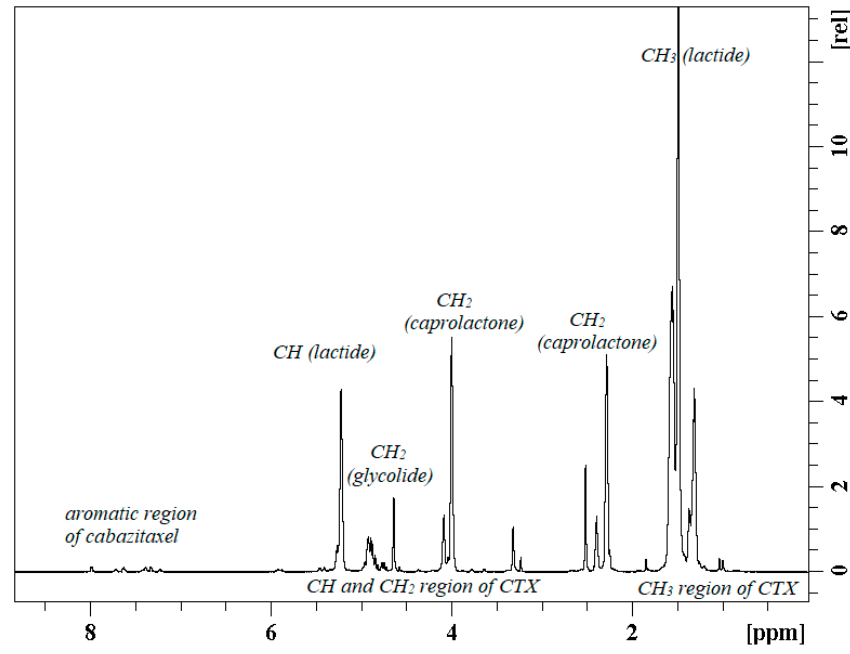
Figure 7. 1 H NMR spectrum of (PGCL/PLGA) + CTX patches in DMSO-d6.